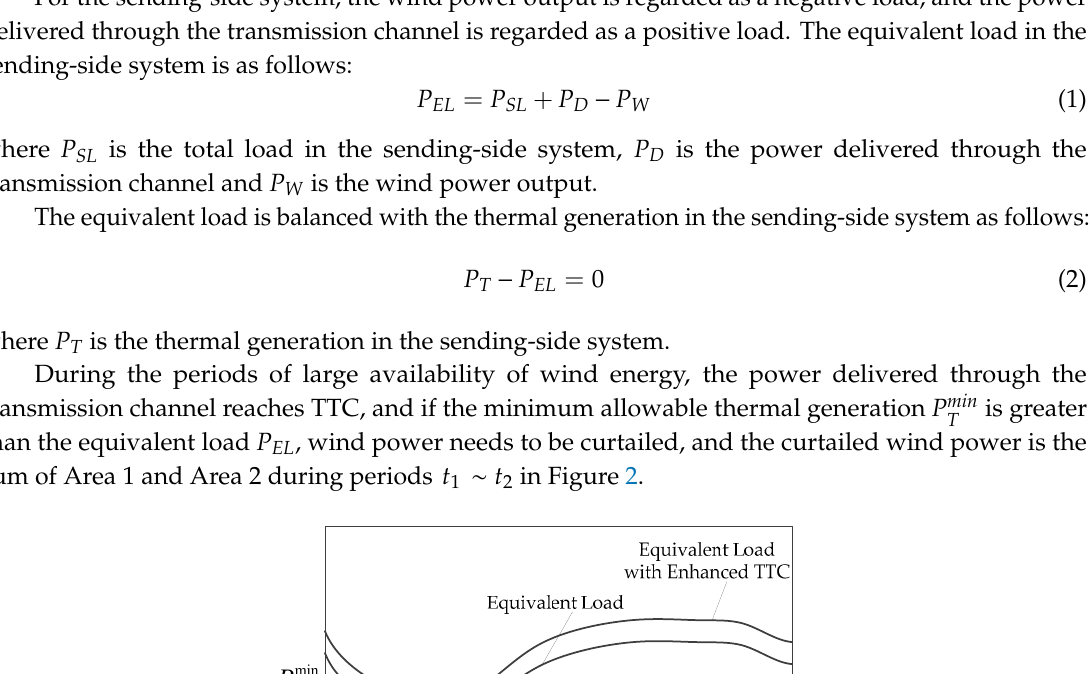
Figure 1. Schematic diagram of sending-side and receiving-side systems and a transmission channel.